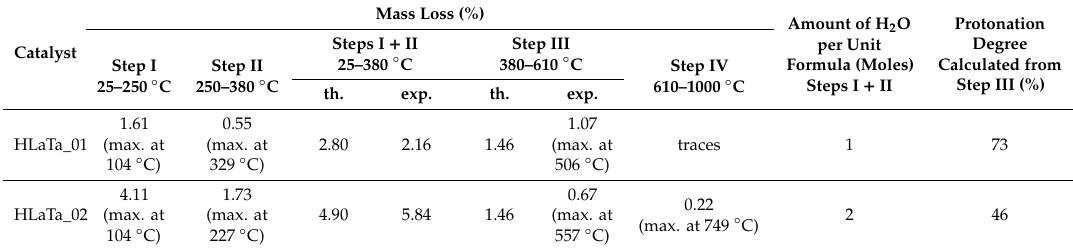
Figure 6. Thermal analyses (TGA, DTG and DTA curves) of ( A ) HLaTa_01 and ( B ) HLaTa_02 protonated layered perovskites with a heating rate of 10 °C·min −1 in air atmosphere. Table 2. Mass loss at di ff erent steps of thermogravimetric (TG) curves, amount of water and exchange degree of HLaTa_01(02) protonated layered